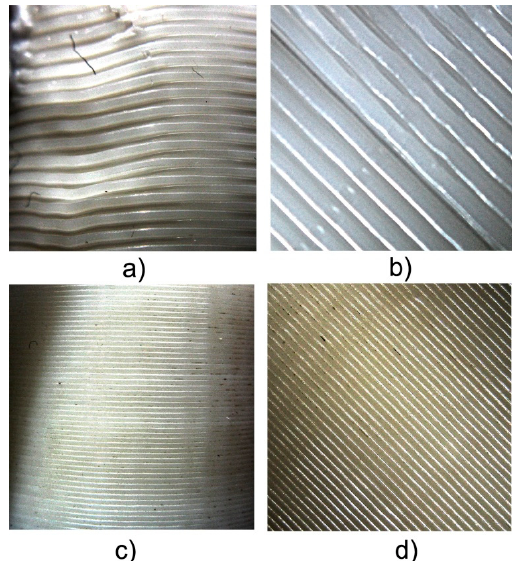
Technologies 2017 , 5 , 50 9 of 12